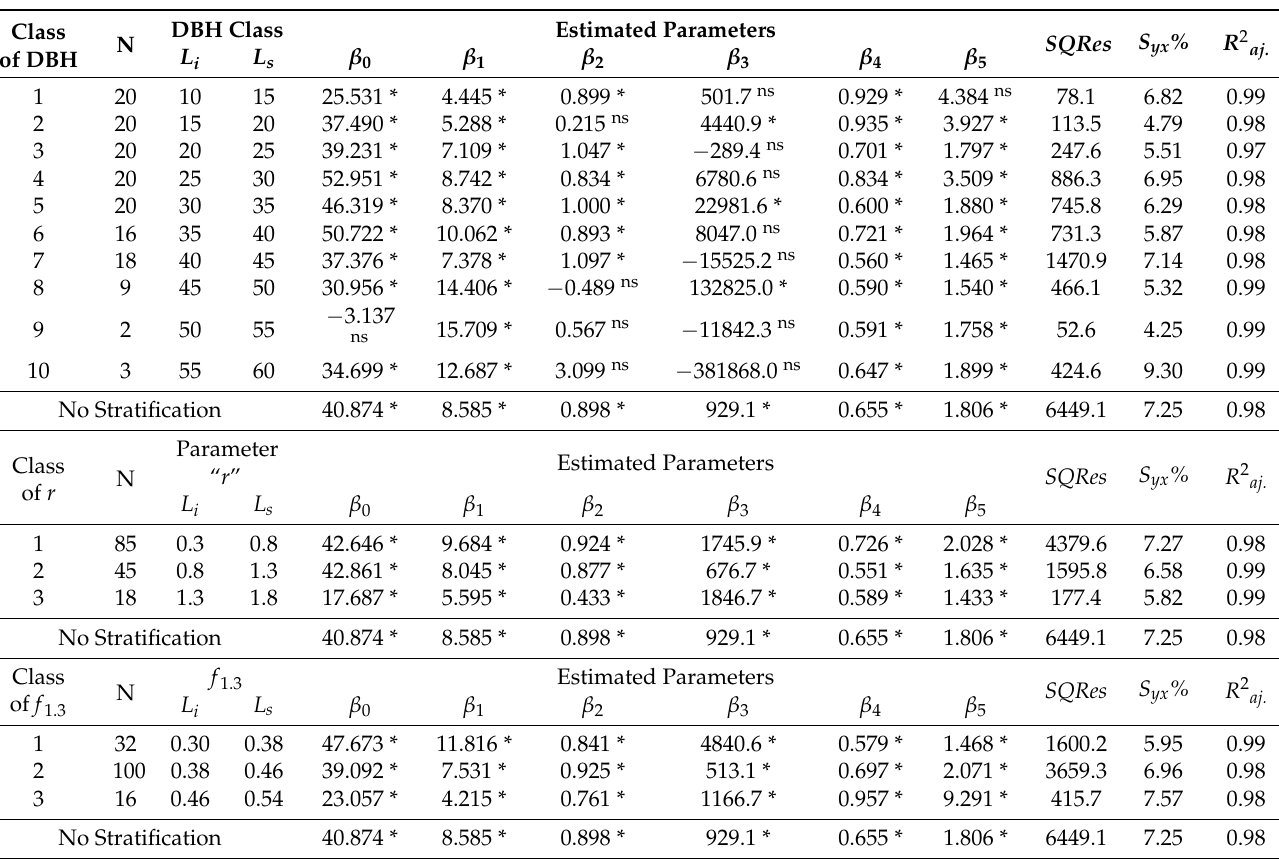
Table 8. Parameters estimated in the adjustments of Clark III et al. model without stratification and with stratification by diameter class at breast height, parameter “ r ” and artificial form factor for Tectona grandis L.f. data, central-west region, Brazil.